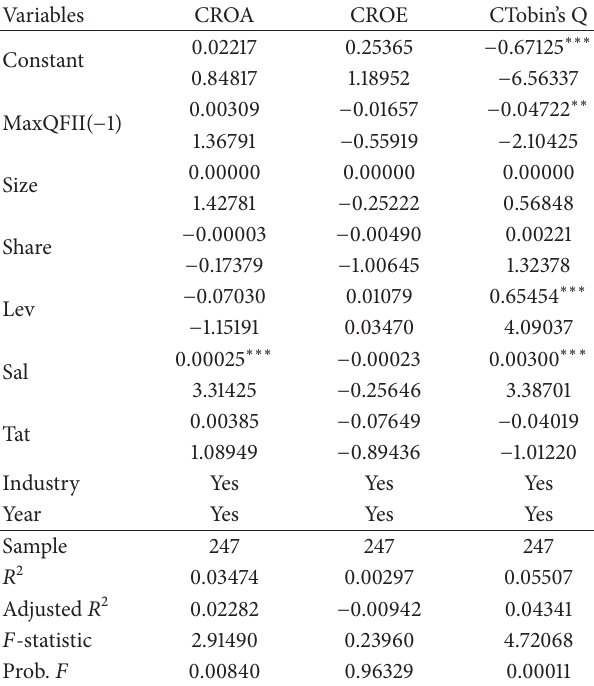
Table 8: Regression results of QFII ratio in period ( 𝑡 − 2 ) and performance improvement indicators according to MODEL